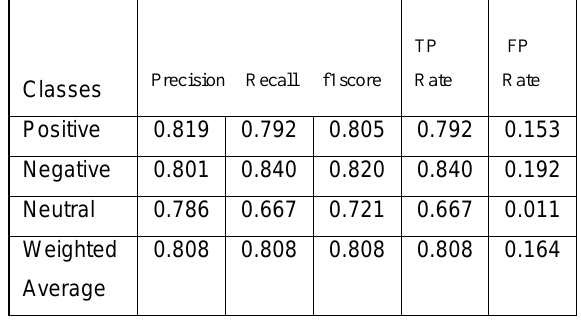
Table 6. Proposed Naïve Bayes Classification with